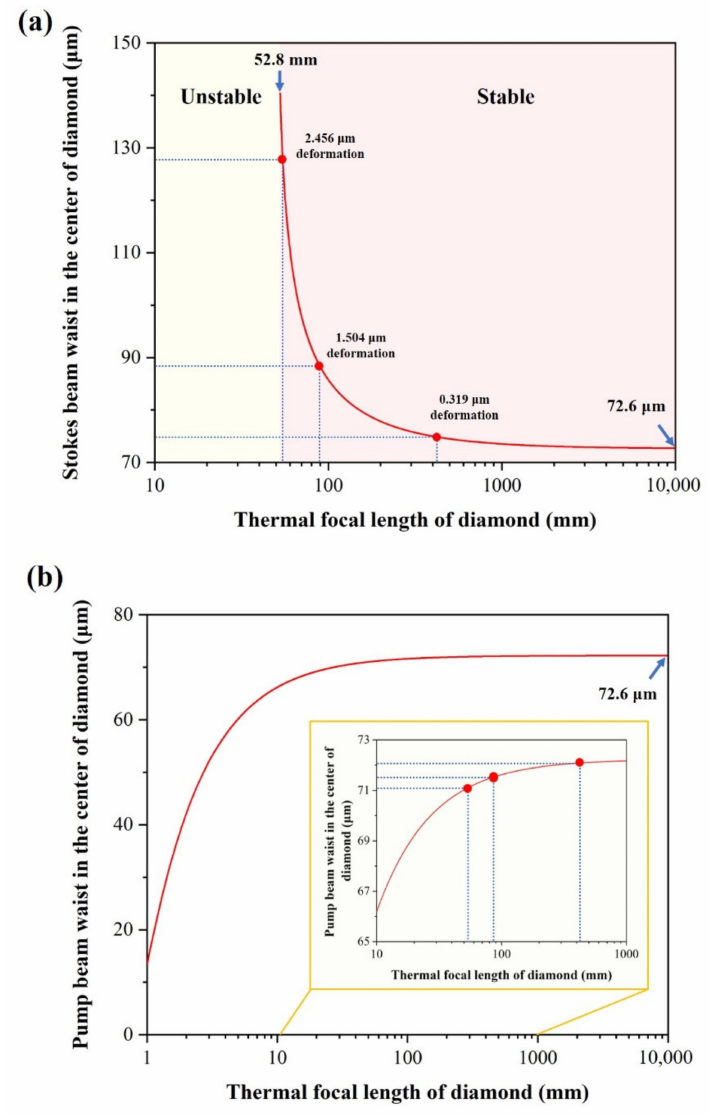
Figure 7. ( a ) Stokes beam waist, and ( b ) pump beam waist as a function of the thermal focal length of